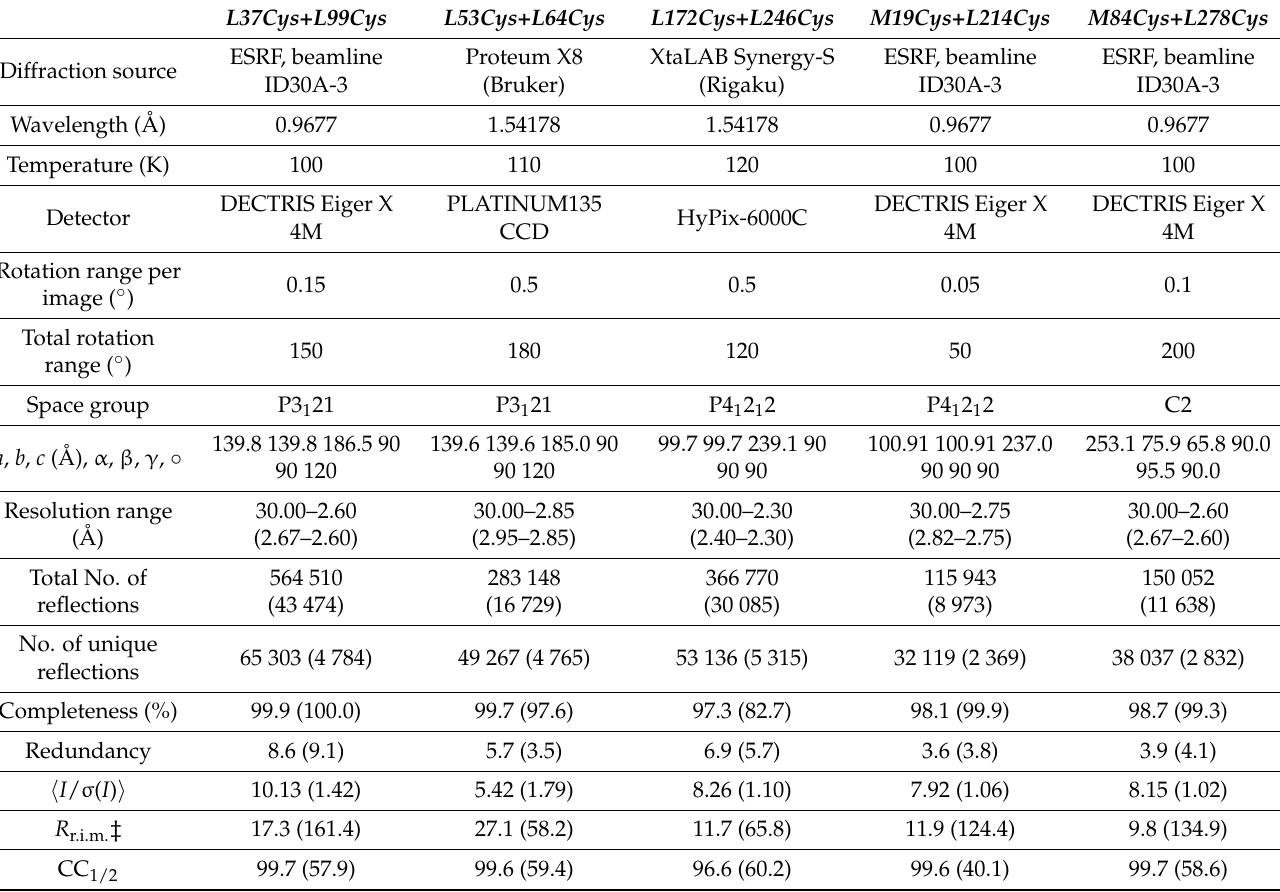
Table 1. Data collection and processing.